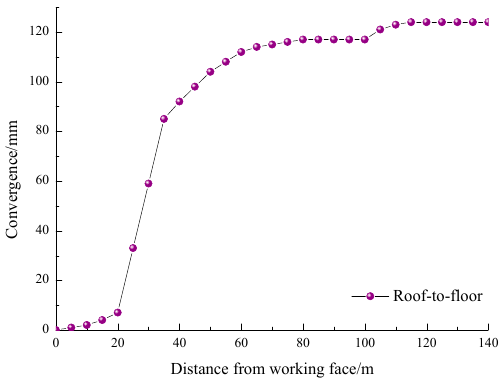
Figure 21. Real-time monitoring curve of roof and floor convergence.